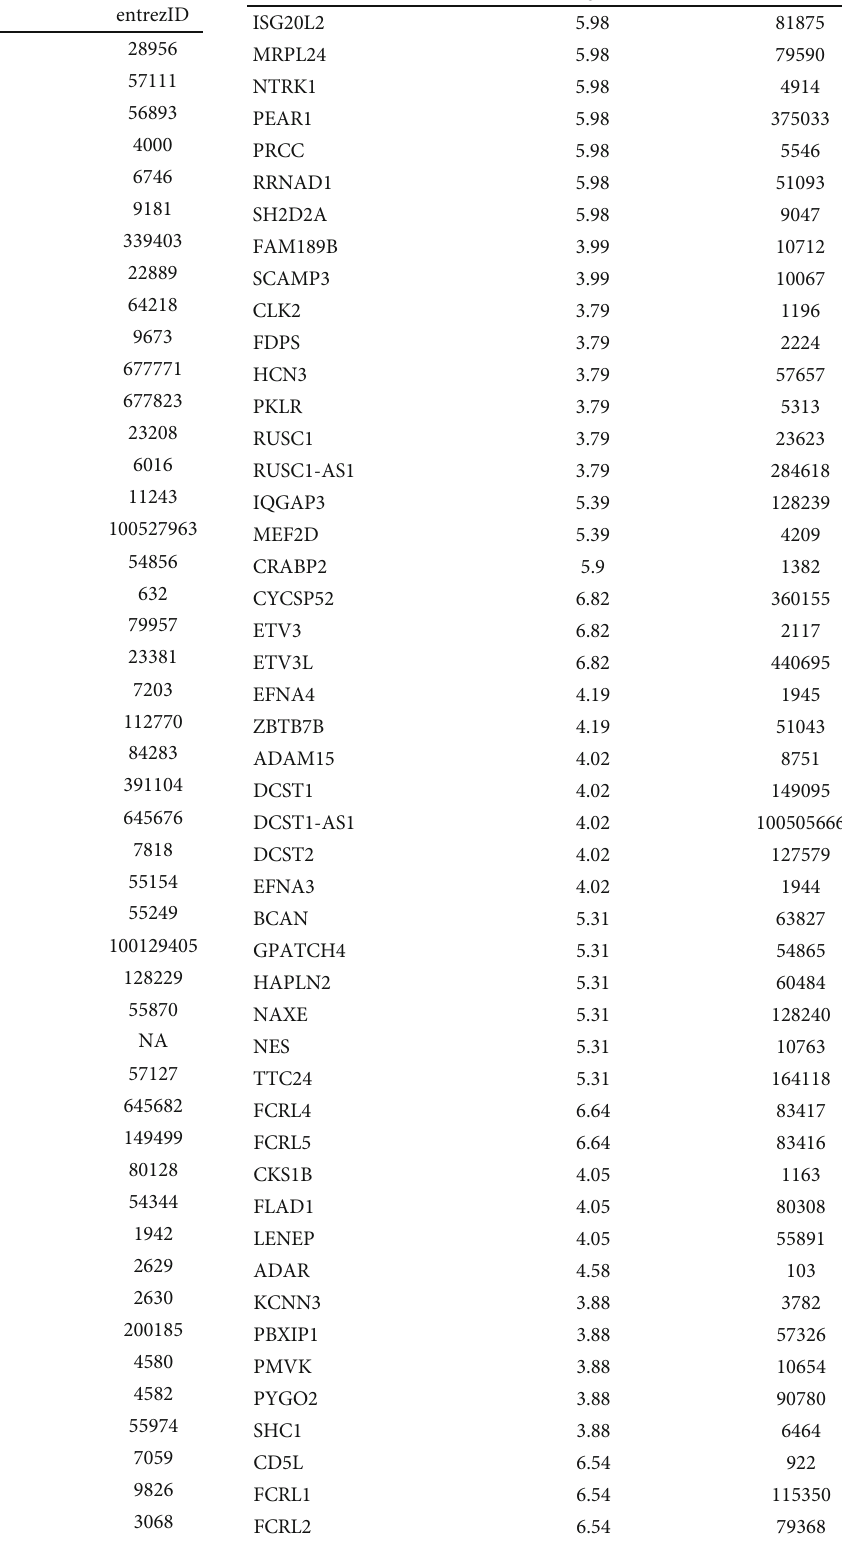
Table 2: The expression of 771 related genes with MEX3A in cBioPortal.